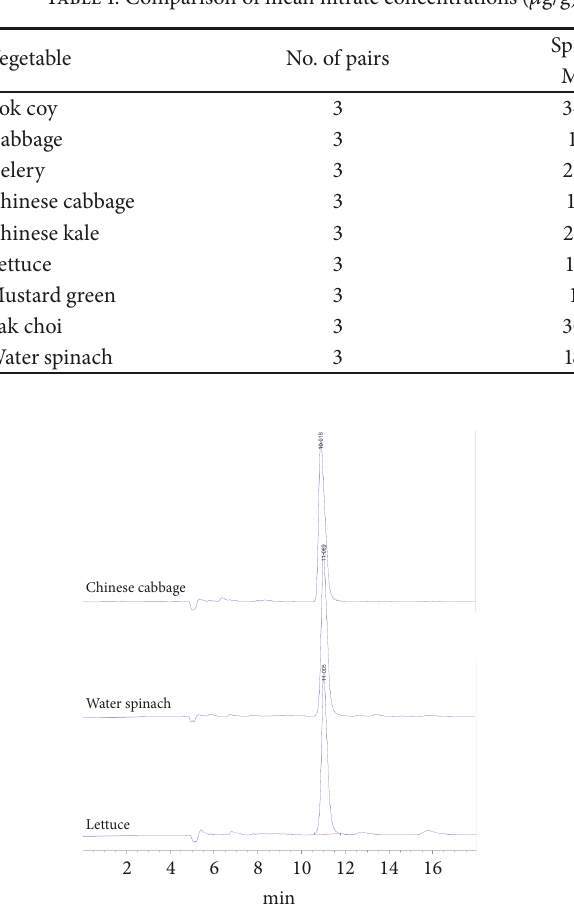
Table 1: Comparison of mean nitrate concentrations ( 𝜇 g/g) between spectrometric and HPLC analyses of various vegetables.